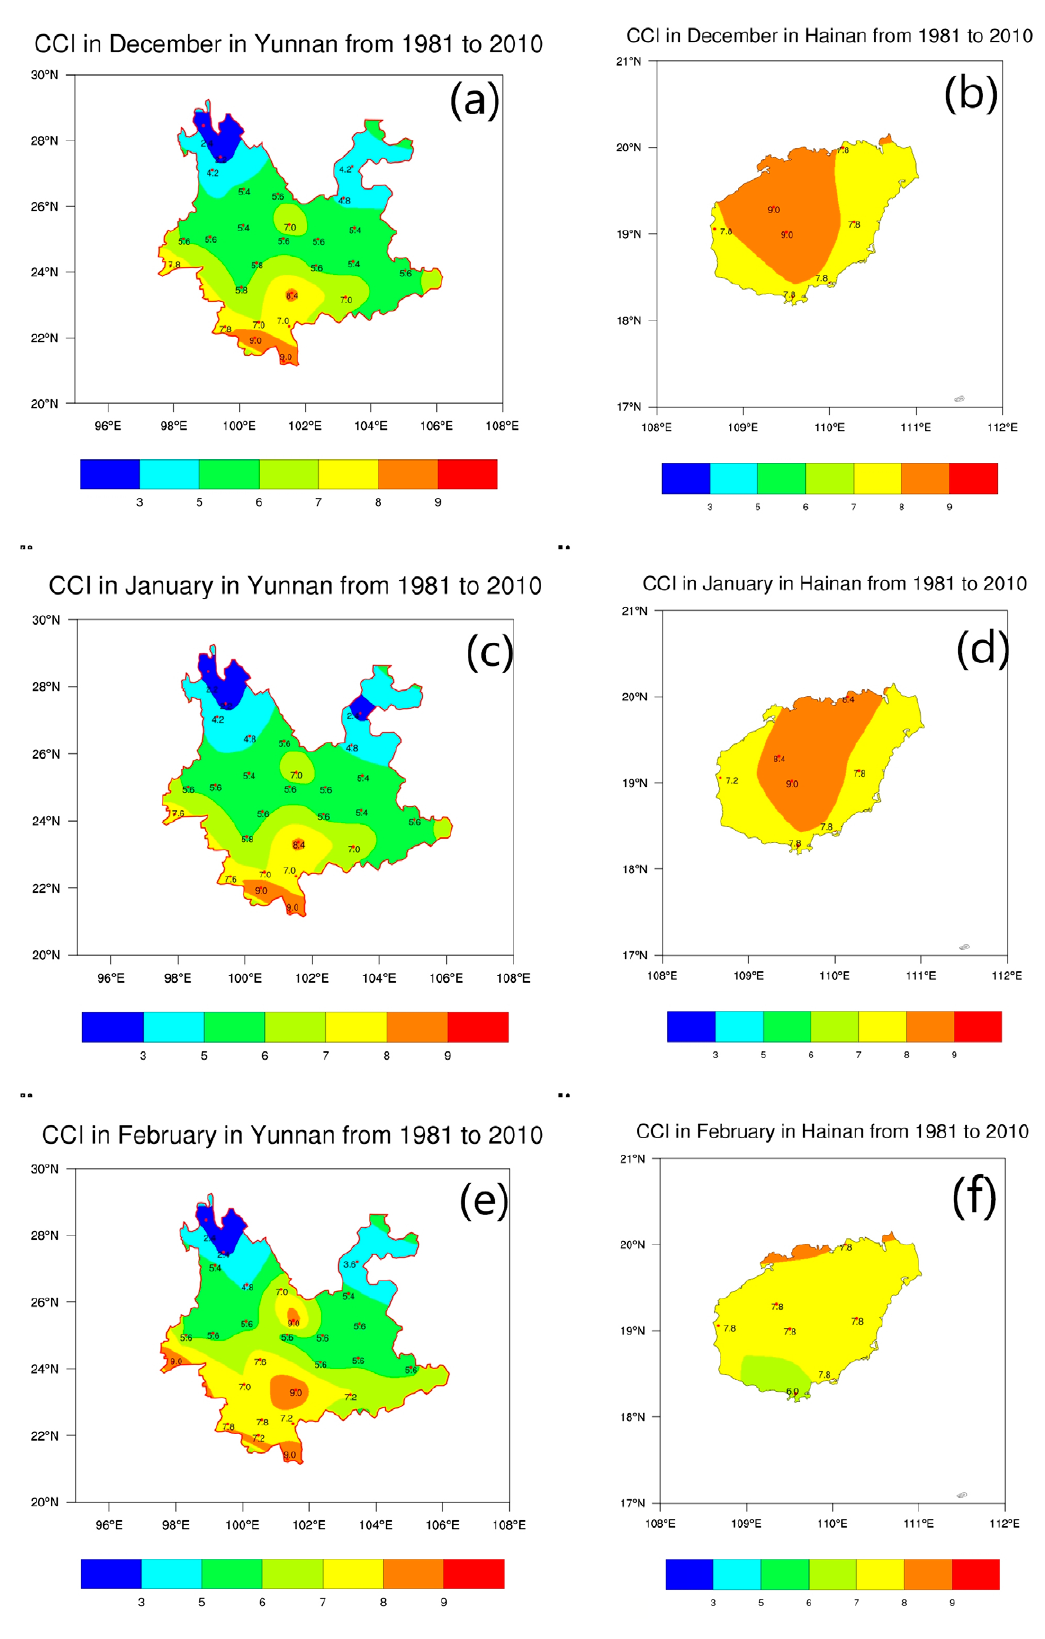
Figure 2. Mean CCI distributions for (a and b) December, (c and d) January, and (e and f) February for the period 1981– 2010. Panels (a), (c), and (e) correspond to Yunnan Province, and Hainan Province is depicted in panels (b), (d), and (f).